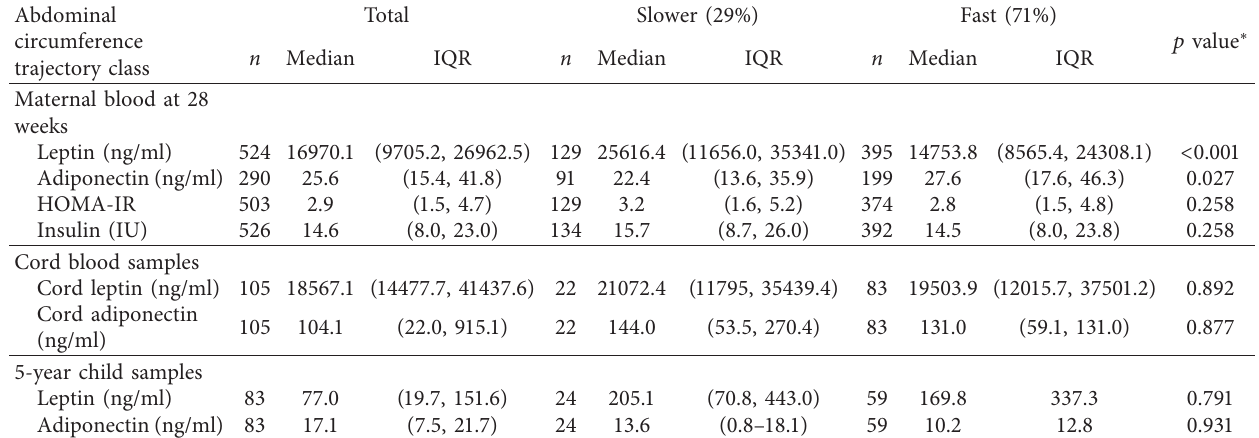
Table 4: Abdominal circumference trajectory (slower or fast) associated with biochemical